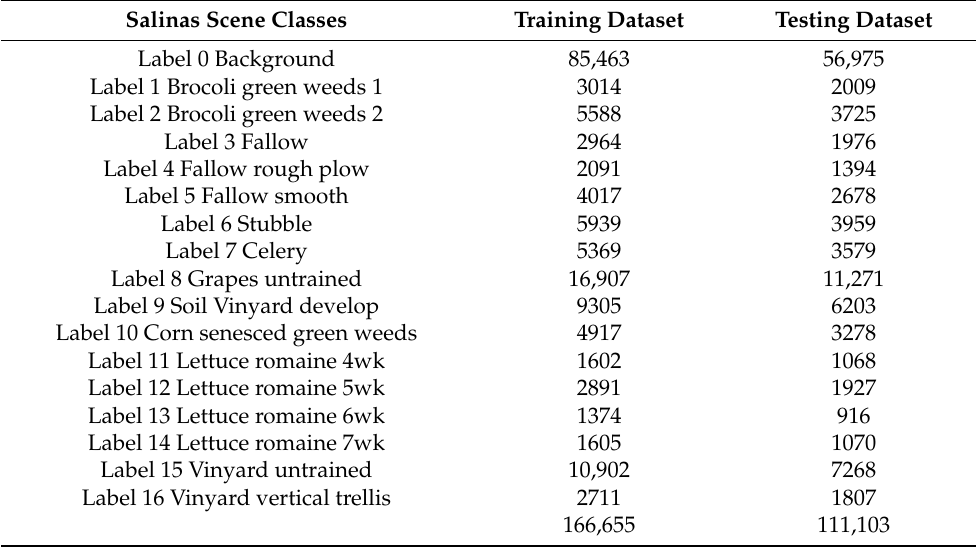
Table 4. Salinas Scene hyperspectral